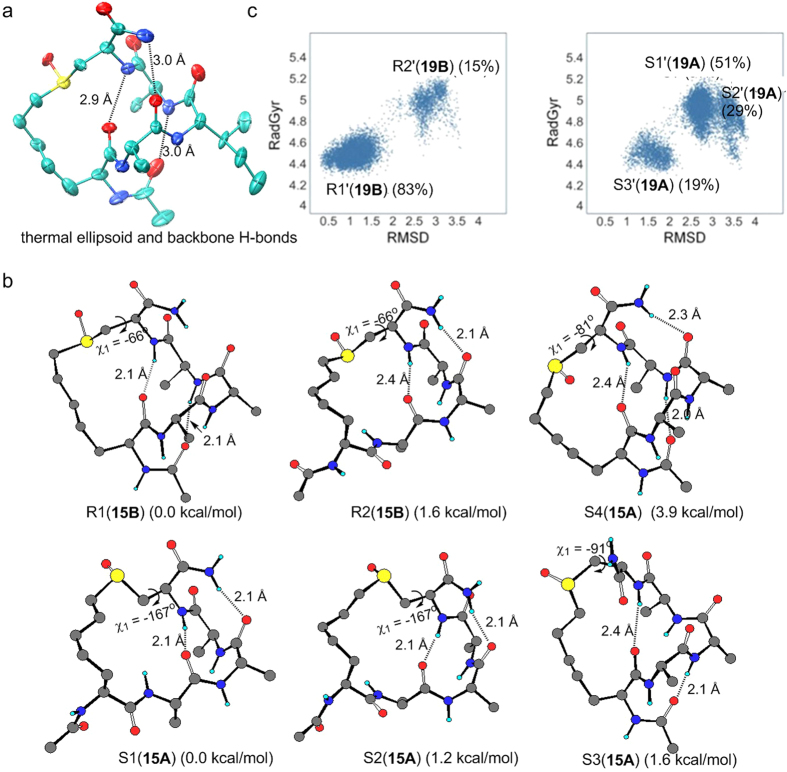
Crystal structure of (R)-19B and calculated structures of (S)-15A, (R)-15B.(a) X-ray crystal structure of (R)-19B with thermal ellipsoids shown at the 50% probability level with three α-helical hydrogen bonds. (b) Conformers of (R)-diastereomer 15B (R1, R2) and (S)-diastereomer 15A (S1, S2, S3, S4) with increased stability, calculated with density functional theory at PBE1PBE/6-31 + G** level. Relative free energies are given below each structure. (c) Conformations sampled in REMD simulations of (S)-19A and (R)-19B. The x-axis is the backbone RMSD of the conformations, with respect to the X-ray structure of (R)-19B. The y-axis is the radius of gyration of the conformations. The clusters are labelled as R1′(19B), R2′(19B) and S1′-S3′(19A), similar to structures R1(15B), R2(15B), and S1-S3(15A) in (b), see SI Fig. 8 for the structures of R1′(19B), R2′(19B) and S1′-S3′(19A).